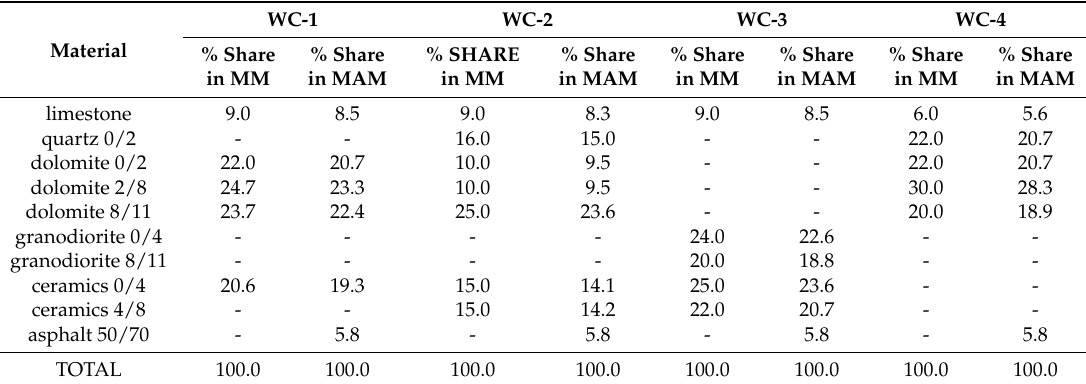
Table 6. Composition of mineral and mineral-asphalt